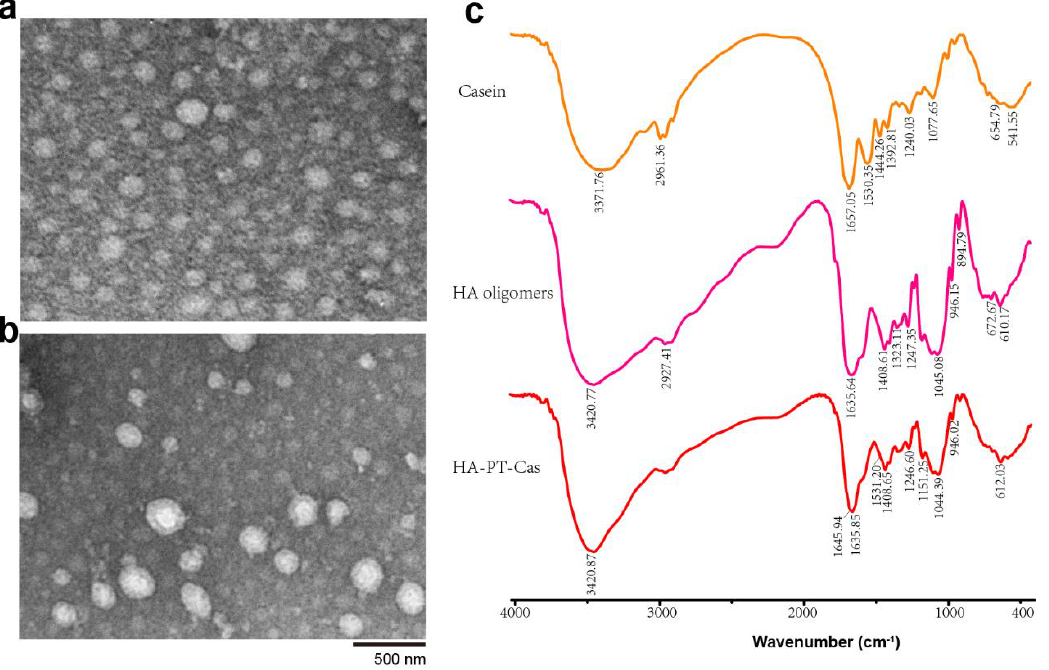
Figure 3. Transmission electron microscopic images of nanoparticles of PT-Cas ( a ) and HA-PT-Cas ( b ); FT-IR spectra of casein, HA oligomers and HA-PT-Cas ( c ). ( b ); FT-IR spectra of casein, HA oligomers and HA-PT-Cas ( c